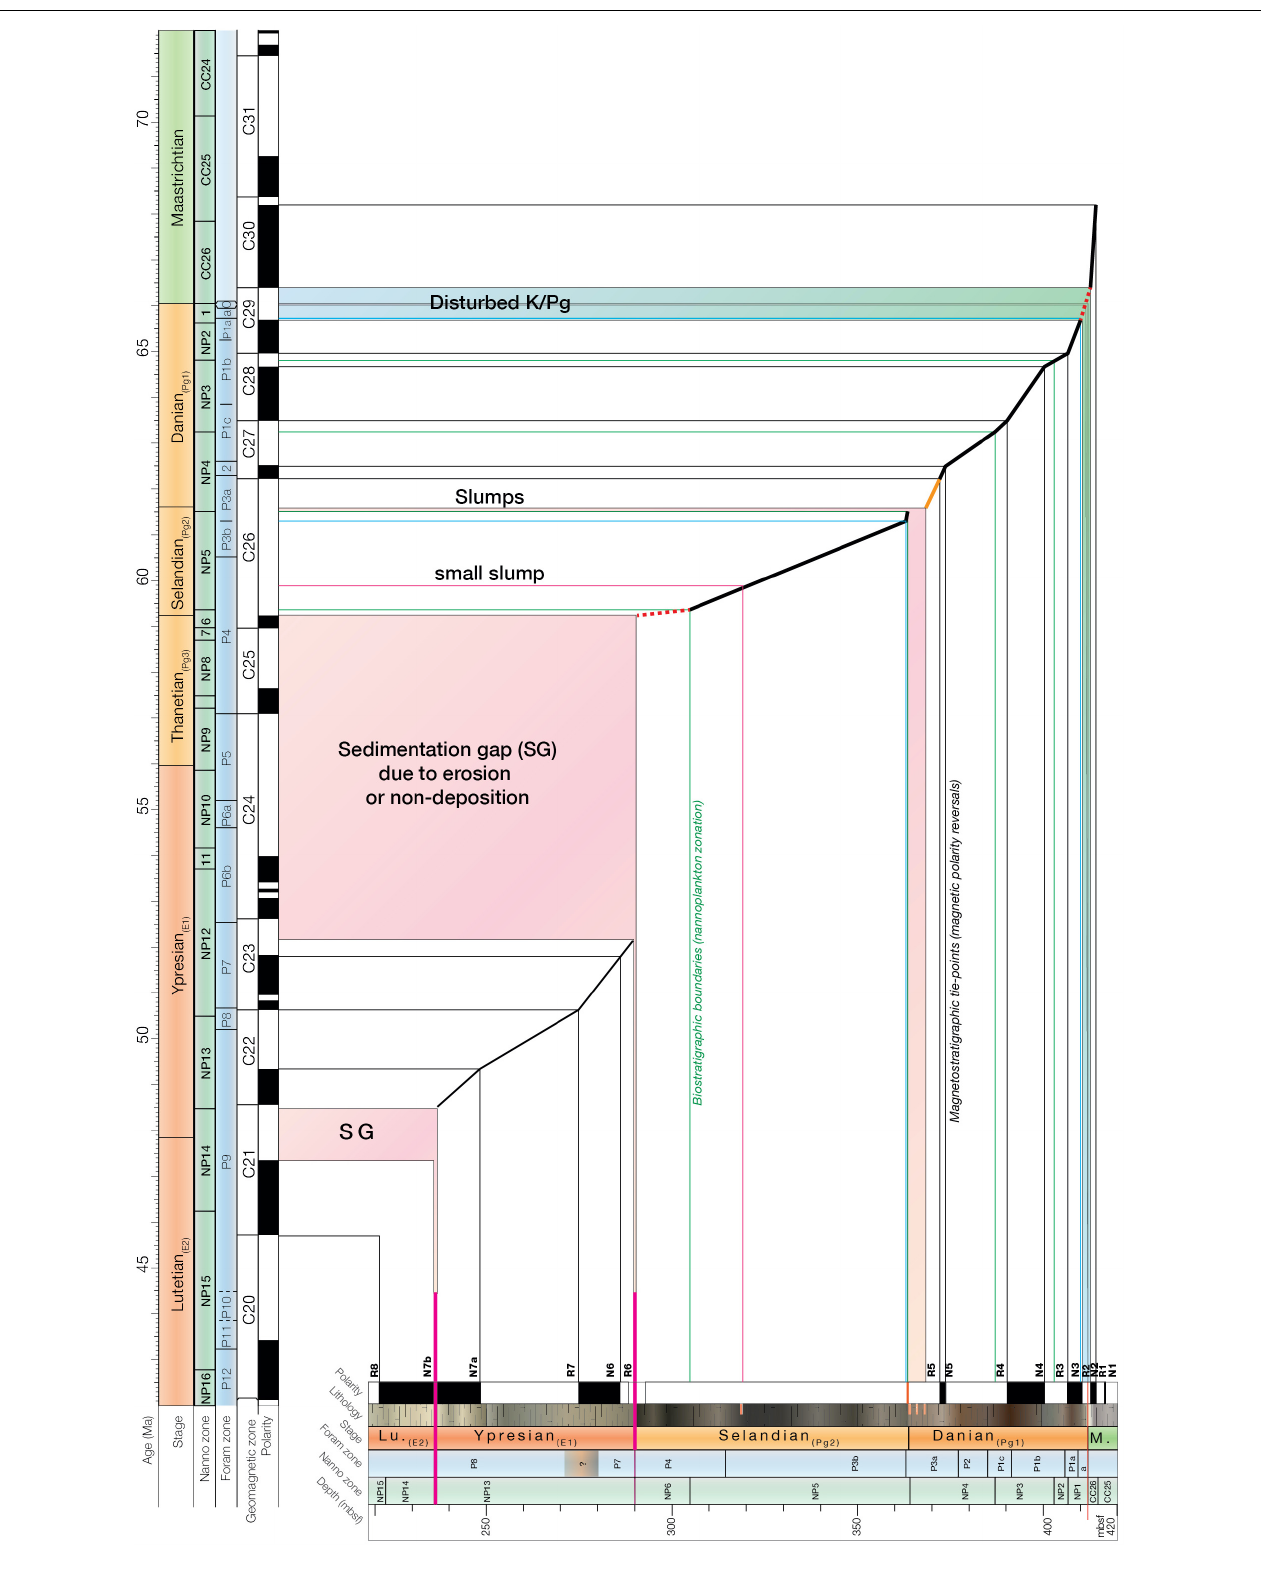
FIGURE 7 | Age model for Site 356 obtained by correlating the reversal pattern and biostratigraphic zonation from site 356 with the Geomagnetic Polarity Time Scale (GPTS 2012). Black lines magnetostratigraphic tie-points, while blue and green lines indicate biostratigraphic tie-points (based on foraminifera zones - blue, and nannoplankton zones –